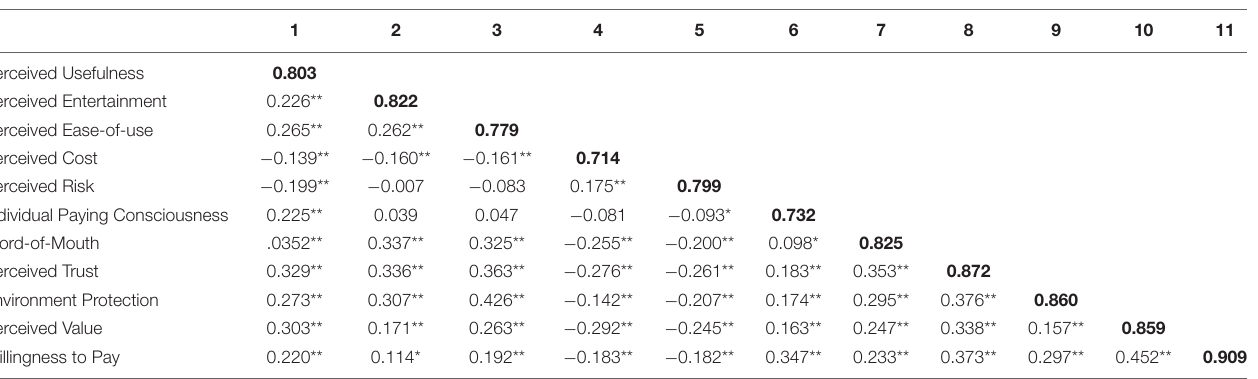
TABLE 4 | Correlation analysis and differential validity.